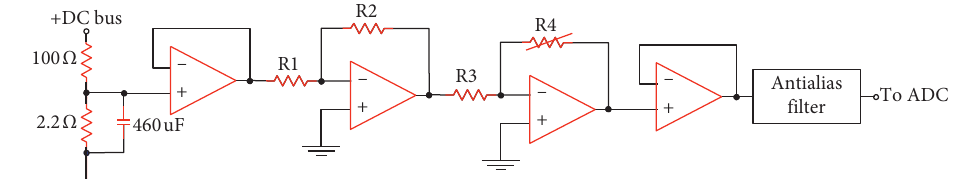
Figure 6: Circuitry for V dc sensing and signal conditioning.